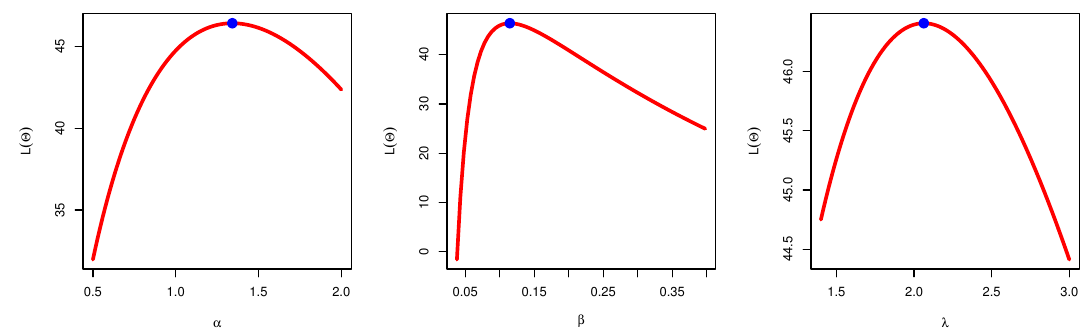
Figure 4. Profile likelihood of UEPD for the recovery rate of COVID-19 data from